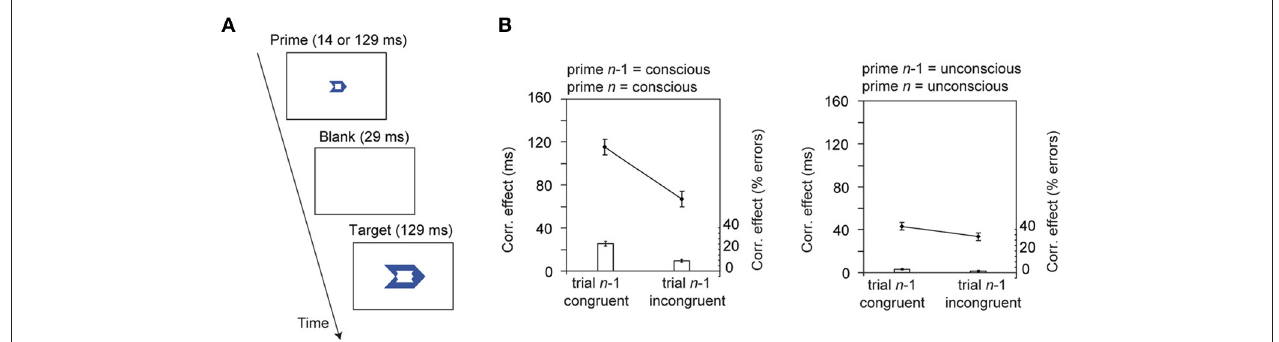
FIGURE 4 | Automatic (unconscious) conflict adaptation effects as shown in van Gaal et al. (2010a). Observers responded to the direction of a target arrow stimulus that had been preceded by a backwards (meta-contrast) masked prime that either corresponded with the response required to the target (as shown in A ), or was non-corresponding. The prime stimulus was either conscious (presented for 129ms) or unconscious (presented for